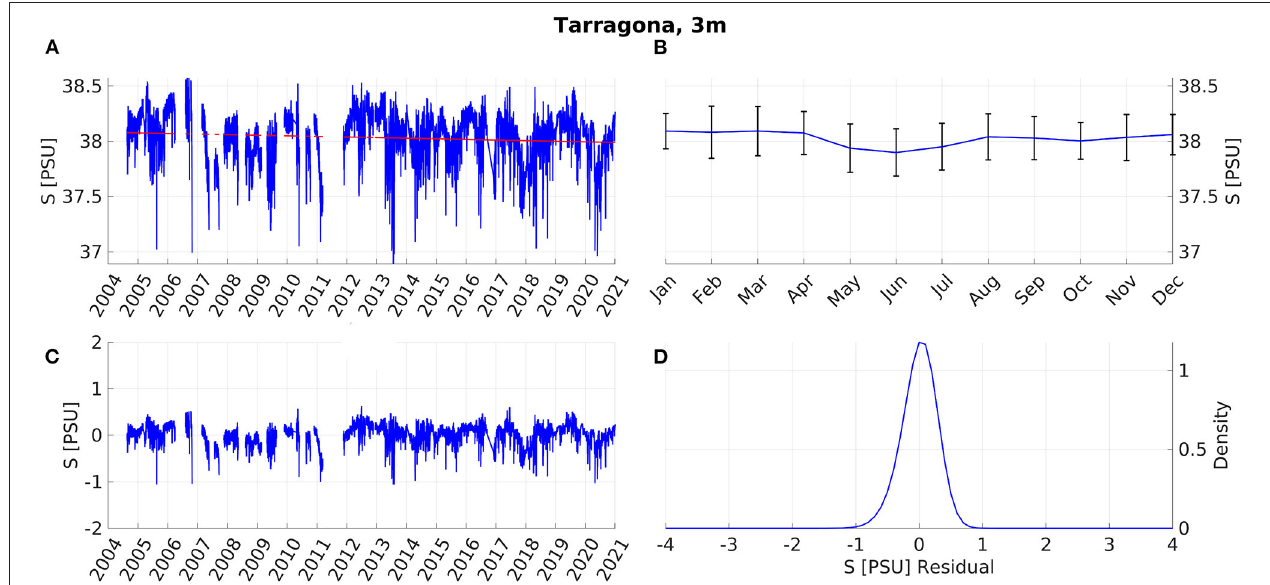
FIGURE 8 | Mooring site characterization of salinity at 3 m depth: (A) reprocessed time series and trend line; (B) monthly climatology and standard deviation; (C) de-seasonalized and detrended time series of residuals; (D) Probability Density Function (PDF) of residuals.